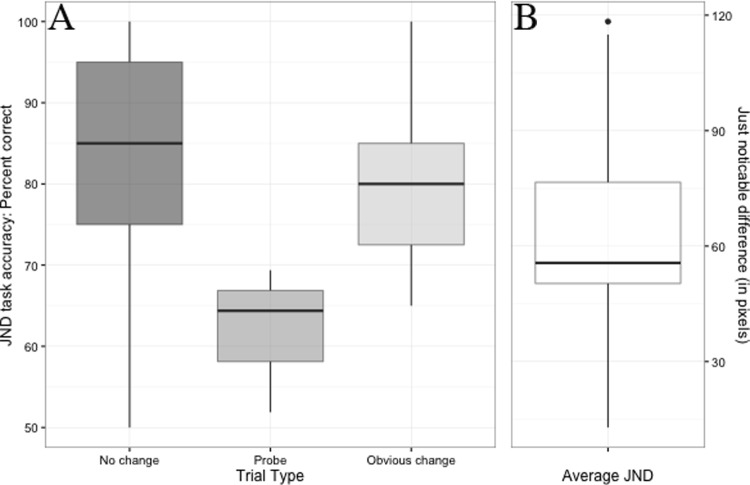
JND estimation task performance.A. Inter-quartile range of participant’s JND estimation task performance for each trials type. The top and bottom of each box represent the 75th and 25th percentile of performance respectively. The bold line within each box represents the median (i.e., 50th percentile) task performance. The length of each whisker represents the extent of the lowest and highest datum that lie within +/- 1.5 times the inter-quartile range. Data points outside of this range are labeled with dots. Performance was significantly lower on probe trails compared to both “no change” and “obvious change” trials. B. Inter-quartile range of participant’s JND. The median JND for our task was 56.41 pixels.